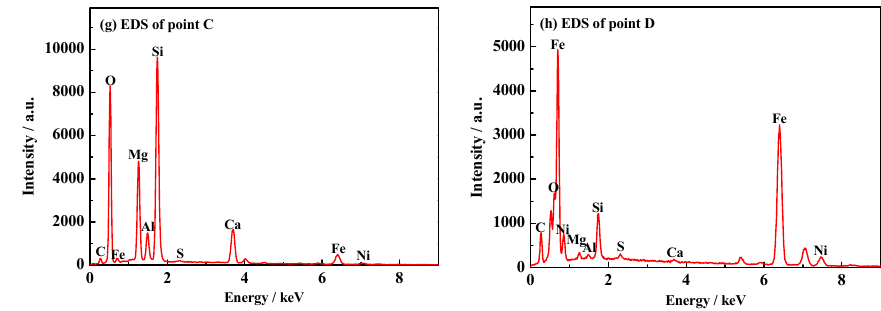
Figure 16. SEM image and EDS spectra of magnetic product particles.